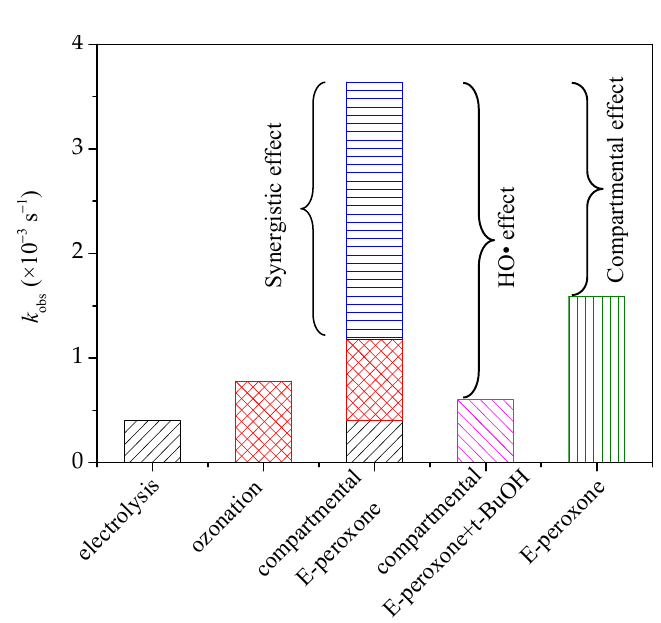
Figure 3. The pseudo first-order reaction rate constants of various treatment processes. (Gas flow rate = 0.2 L/min; Inlet O 3 concentration = ~20 mg/L; Applied current = 20 mA/cm 2 ; Initial solution pH = 6.9; Temperature = 25 ± 2 °C).